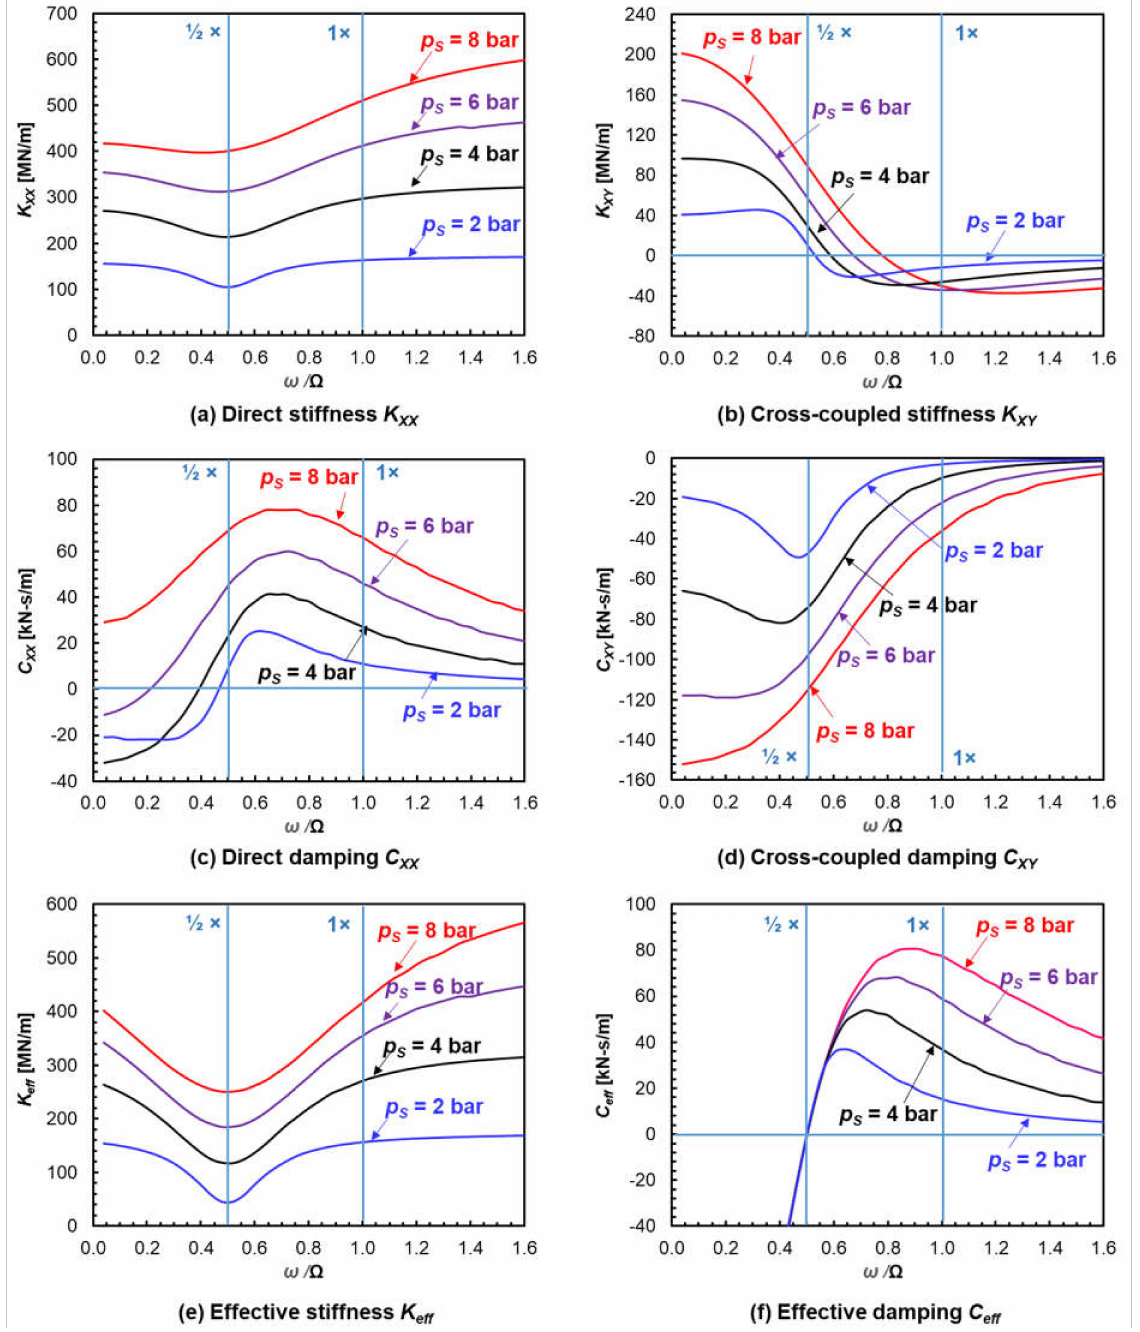
Figure 7. PGB force coefficients vs. frequency ratio ( ω / Ω ). Mean operating speed Ω * = 25 krpm (417 Hz); ( a , b ) stiffnesses ( K XX , K XY ), ( c , d ) damping coefficients ( C XX , C XY ), ( e , f ) effective stiffness ( K eff ) and damping ( C eff ) coefficients. Supply pressure p S = 2 to 8